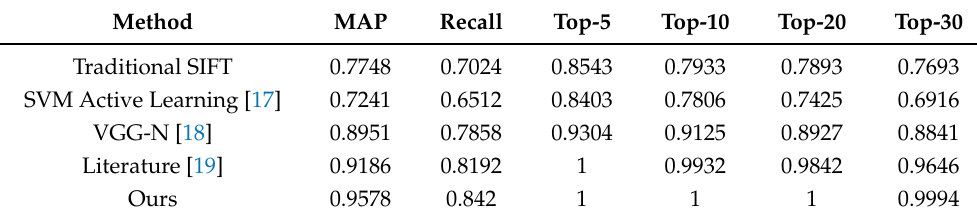
Table 1. MAP, recall and Top-n of different methods on the dataset